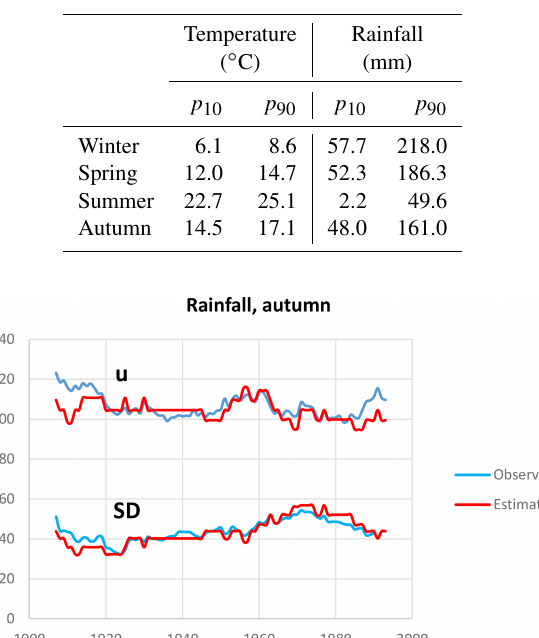
Table 2. Percentiles 10 and 90 of seasonal mean temperature (SDATS; Brunet et al., 2006) and total rainfall in Granada from 1895 to 2005 (AEMET; Luna et al., 2012).